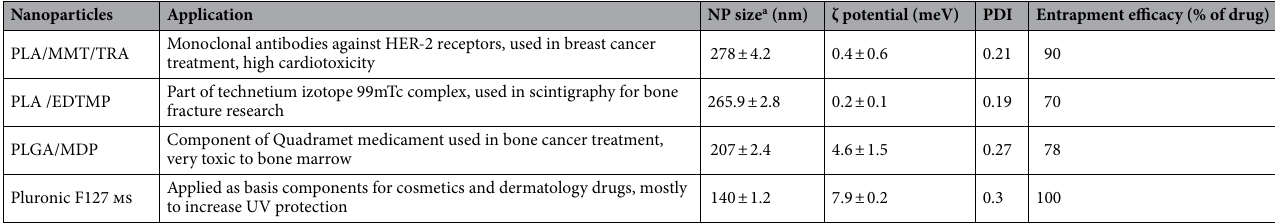
Table 1. Physicochemical properties of investigated particles: size distribution, zeta-potential, PDI, and entrapment efficacy of PLA/MMT/TRA, PLA/EDTMP, PLGA/MDP, and Pluronic F127 Ms. a The size from each nanosystem has been confirmed by TEM or AFM analysis and the results were similar with the DLS